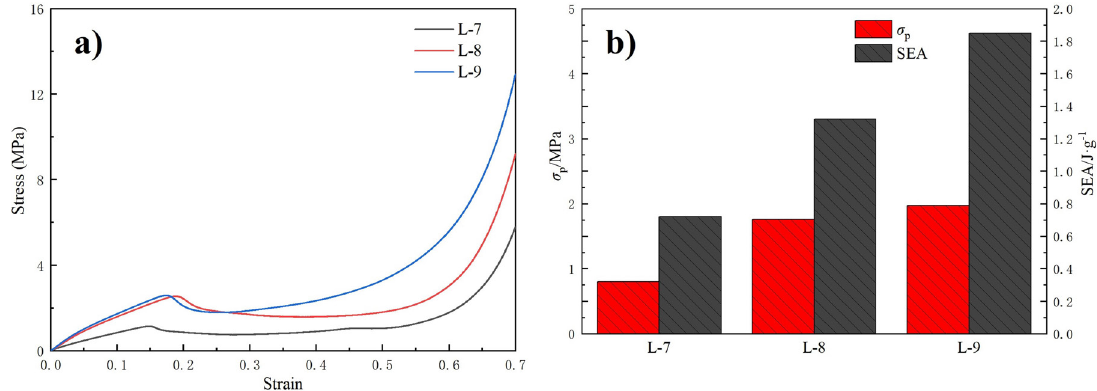
Figure 9. a) Stress-strain curves of different curvature k, b) Platform stress and SEA of different curvature